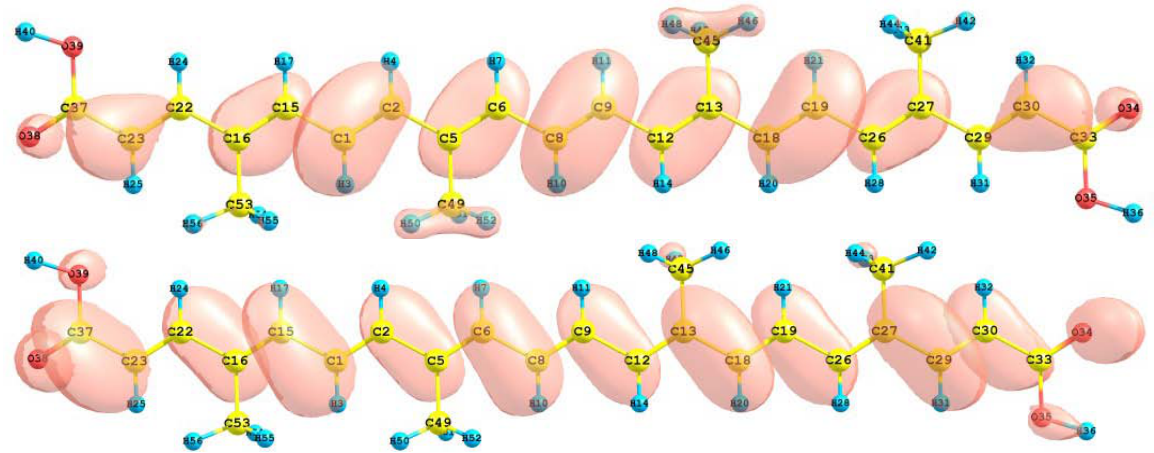
Figure 7. HOMO and LUMO of the norbixin molecule calculated at the M05-2X/6- 31+G(d,p) level of theory.